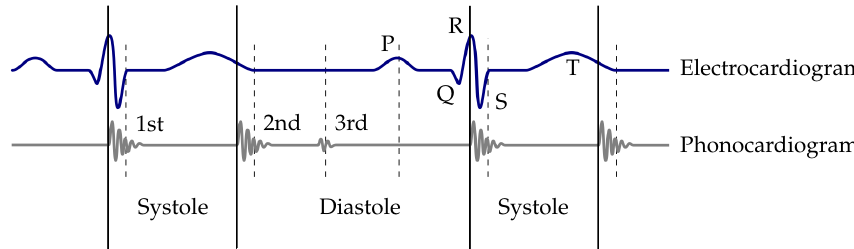
Figure 1. Wiggers diagram: the blue curve shows the ECG and the grey curve the related heart sounds (PCG). A heart cycle is defined as a sequence of a systole and a diastole